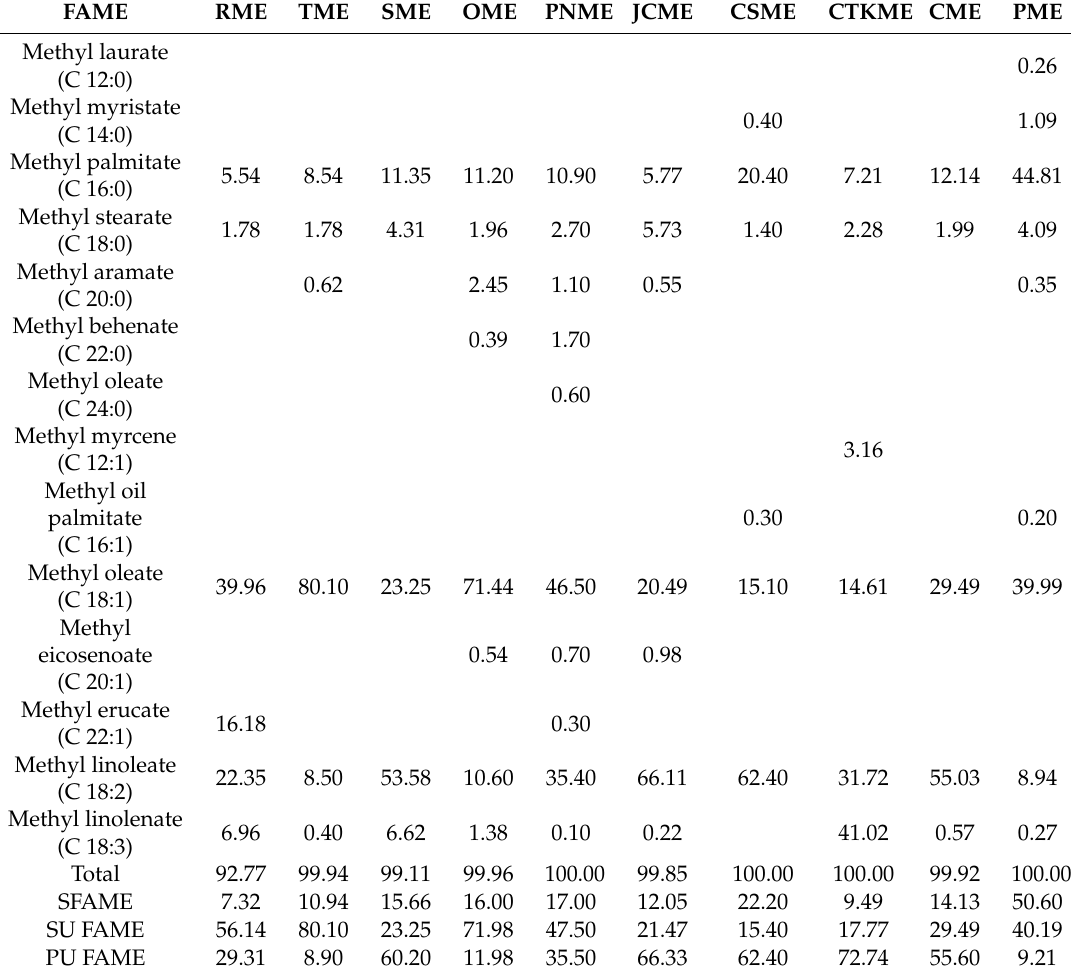
Table 2. Composition of biodiesel fatty acid methyl ester.